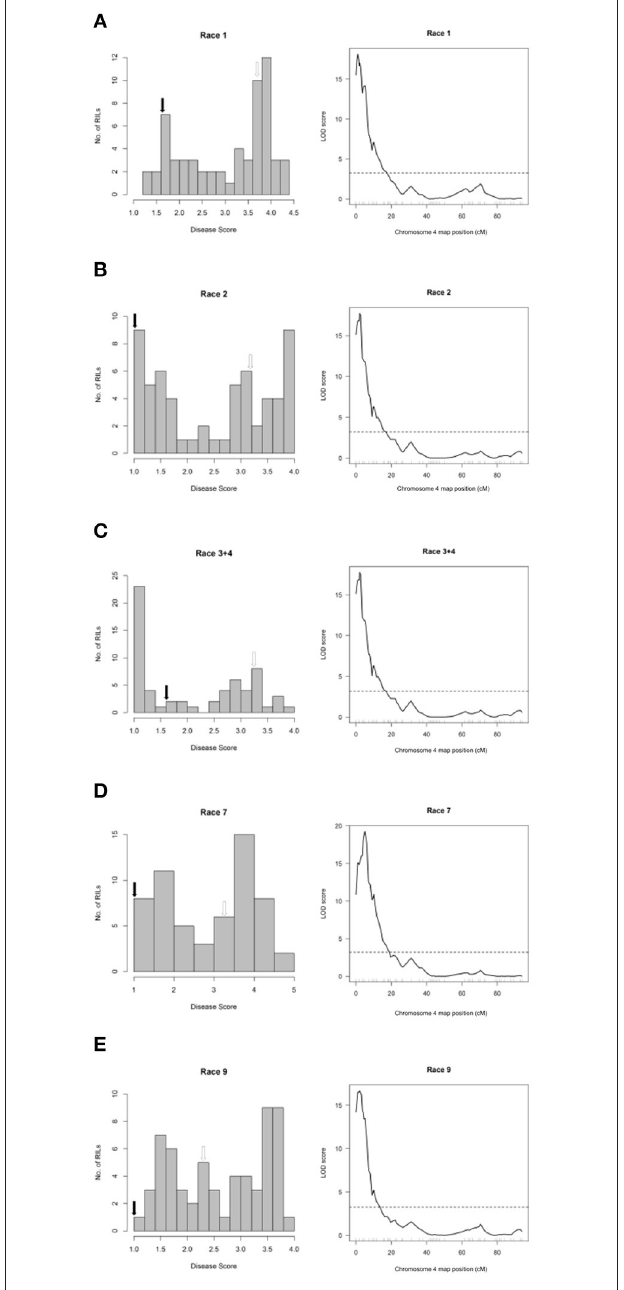
FIGURE 4 | Resistance mapping in the Phaseolus vulgaris Canadian Wonder × PI 150414 (CP) recombinant inbred population following separate inoculations with (A) Race 1, (B) Race 2, (C) Race 3 + Race 4 (mixture), (D) Race 7, or (E) Race 9 of Pseudomonas syringae pv. phaseolicola detects co-localizing major-effect QTL on Pv04. (Left graphs) Distribution of interaction phenotypes exhibited by CP inbreds in glasshouse experiments. The phenotype scale ranges from highly resistant (score 1.0) to fully susceptible (score 5.0). White arrows denote the mean disease score for Canadian Wonder and black arrows denote the mean disease score for PI 150414. (Right graphs) LOD profiles obtained by one-dimensional and two-dimensional genome scans. QTL models were fitted and refined using the multiple imputation method. Dashed lines denote significance at the 0.05 probability